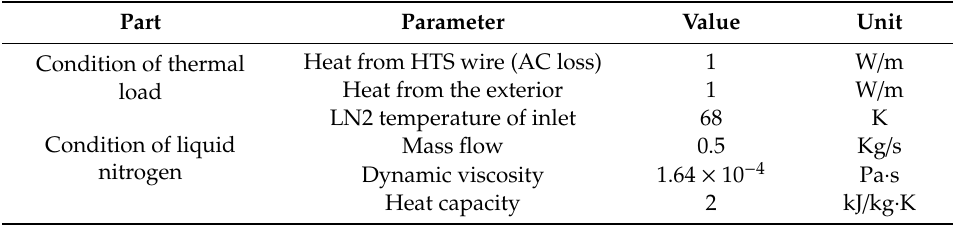
Table 2. Parameter for thermal analysis.